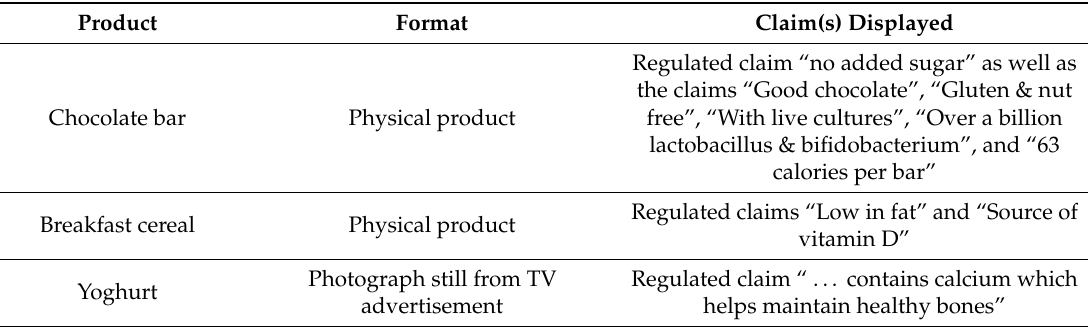
Table 2. Overview of materials used in focus